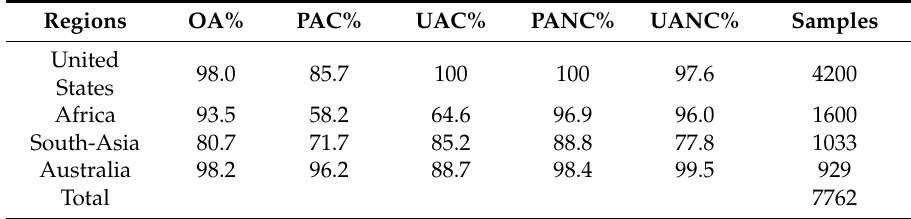
Figure 6. The distribution of reference samples distributed in the four regions (Source: Independent datasets generated by assessment team and field data collected for Australia [6,11]) used to assess GFSAD250m cropland extent map. Table 9. The accuracy measures of the GFSAD250m cropland extent map.